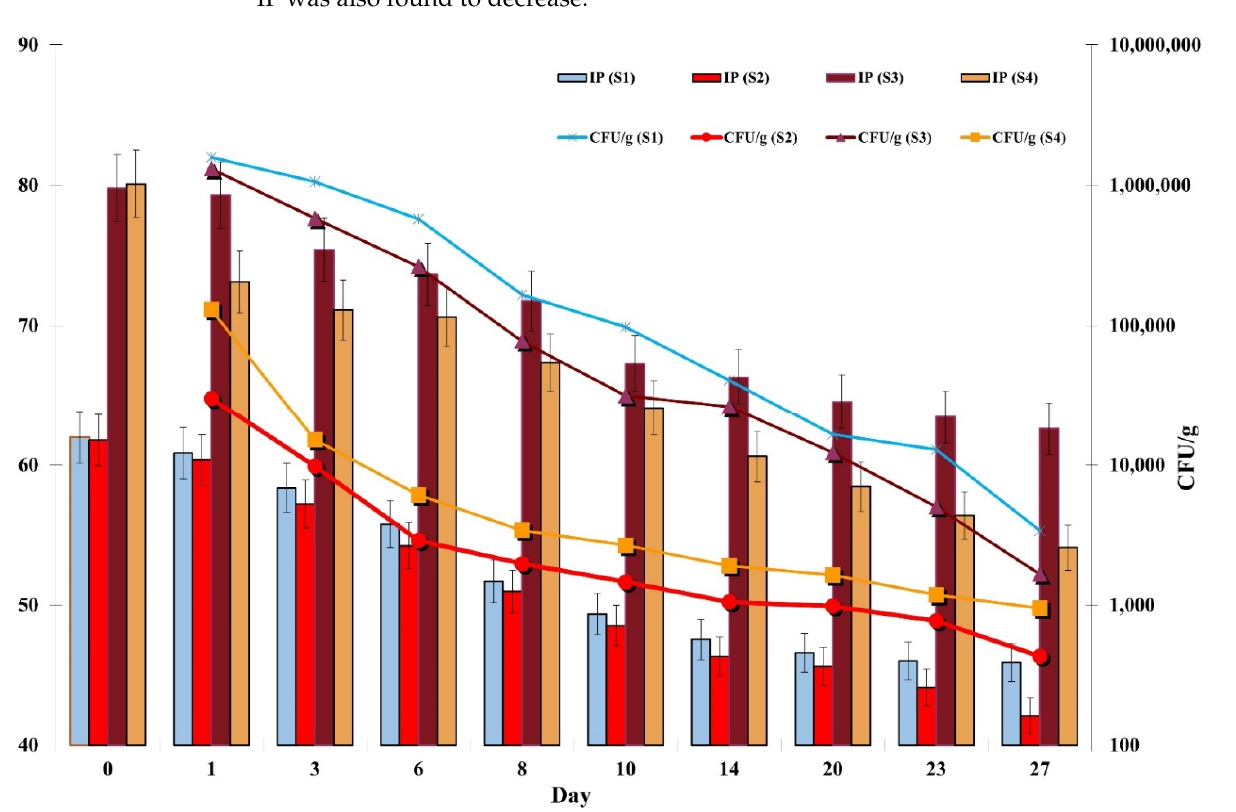
Figure 1. Induction periods (IP) and colony-forming units (CFUs) per g of lipid phase of tzatziki samples S1‒S4 during 27 days of storage.